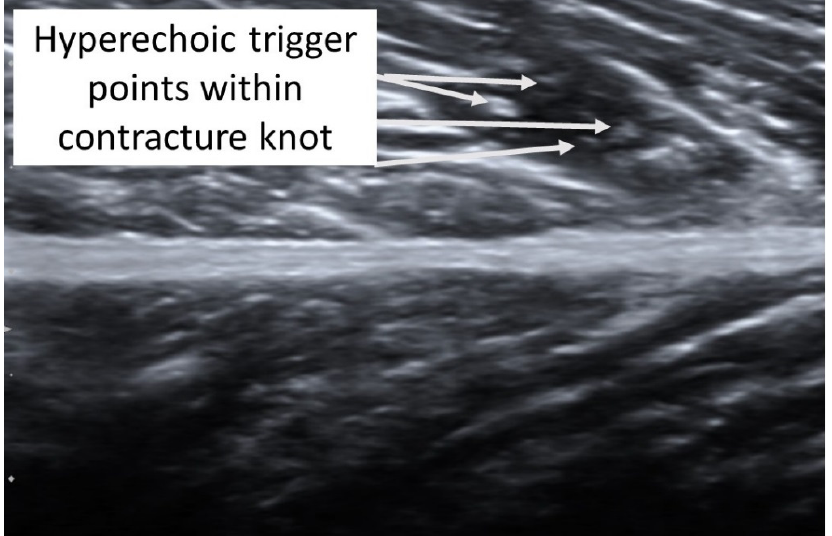
Figure 2. Detailed ultrasound imaging assessment of the right gastrocnemius muscle showing a collection of small hyperechoic (hypoperfused) “TrP speckles” within the contracture knot. In addition, taut bands with palpable nodules responsible for his right shoulder pain were also identified in the right anterior and middle deltoid muscles. As had been the case with previous bouts of shoulder complaints, the subject reported, upon palpation, a referred pain symptom spreading down the anterior and middle aspect of his upper extremity. The spots were subsequently imaged in short-axis with a Siemens Acuson S200 Ultrasound system with an 18L6 16 Hz high-definition linear probe. Two large hypoechoic